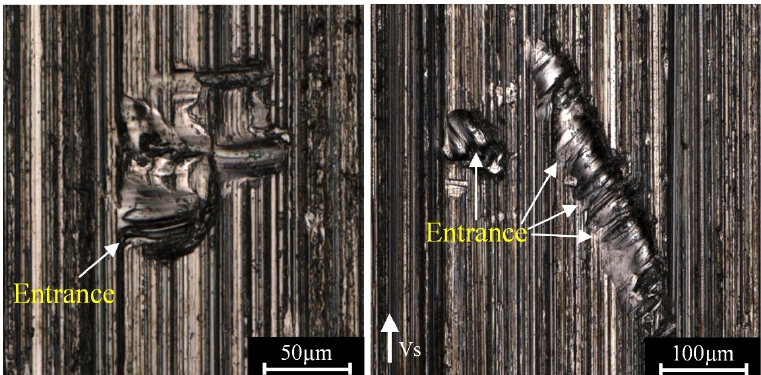
Figure 6. Typical surface morphology of adhesive chips.